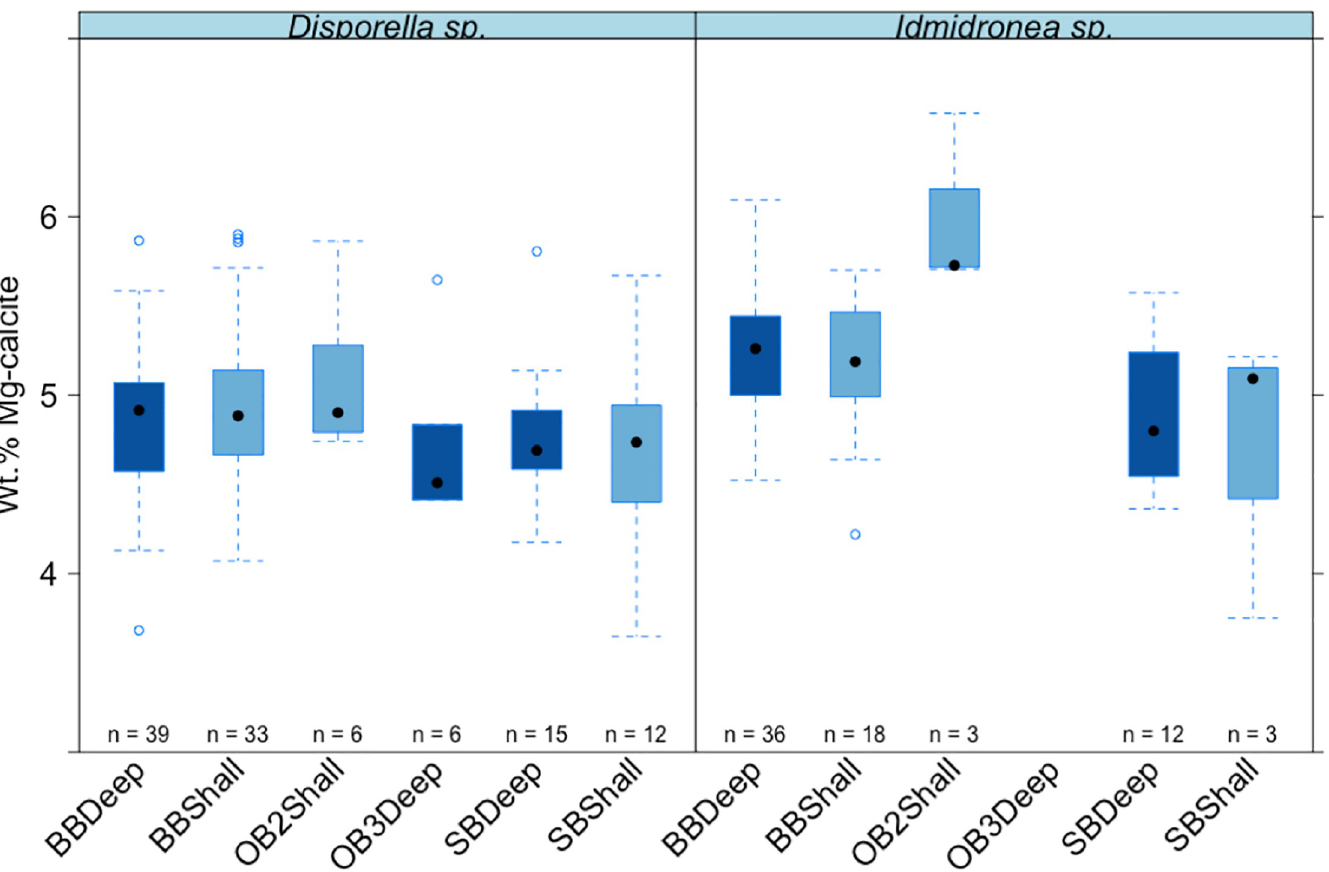
Fig 6. Mean values ( ± standard error) of wt% MgCO 3 in calcite in the two Antarctic cyclostome species among different sites and depths. Boxes depict standard deviation around mean (mid-line); tail indicates range. Colours indicate deep and shallow waters. � Brown Bay = BB , OB2 = O'Brien Bay -2 , OB3 = O’Brien Bay-3 , SB = Shannon Bay . Deep = Deep , shallow = Shall